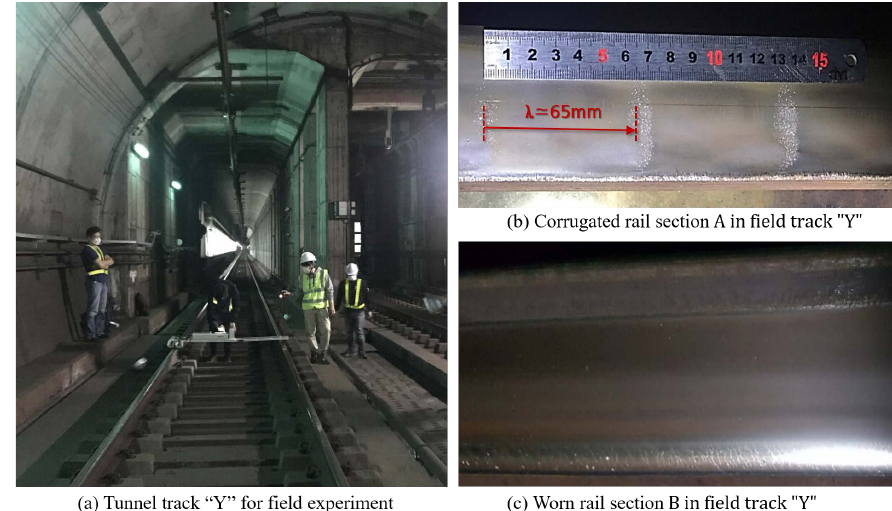
Figure 8. Railway track field experiment; ( a ) Tunnel track “Y”, ( b ) Corrugated rail section A, ( c ) Normal rail section B.